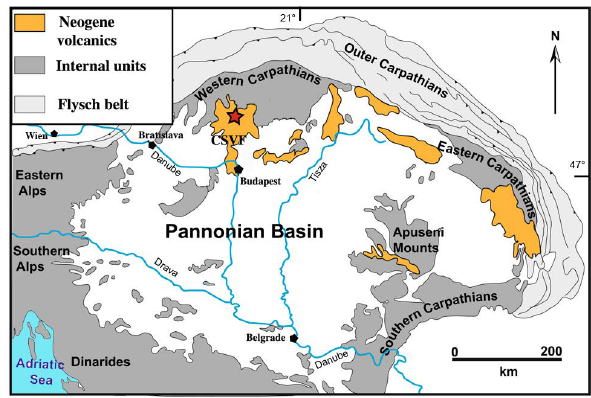
Figure 1: Simplified geological map of the Carpatho- Pannonian region, showing the distribution of the Neo- gene volcanic rocks (coloured) and the location of the andesitic dome near the village of Breziny (red star). CSVF = Central Slovakia Volcanic Field. Slightly modi- fied after Didier et al.